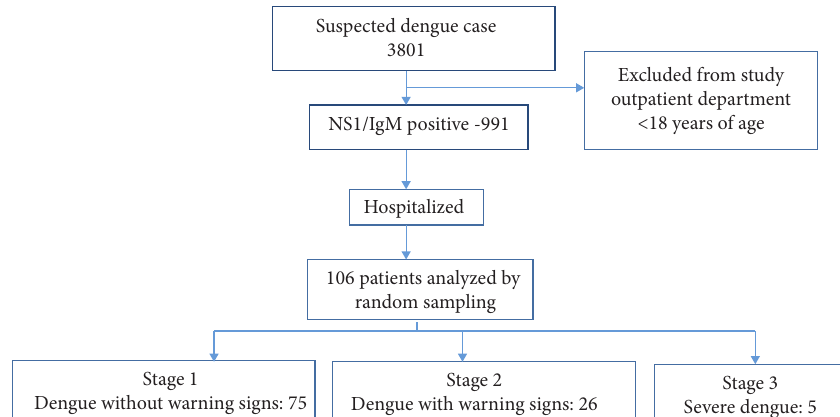
Figure 1: Flowchart depicting the case distribution.